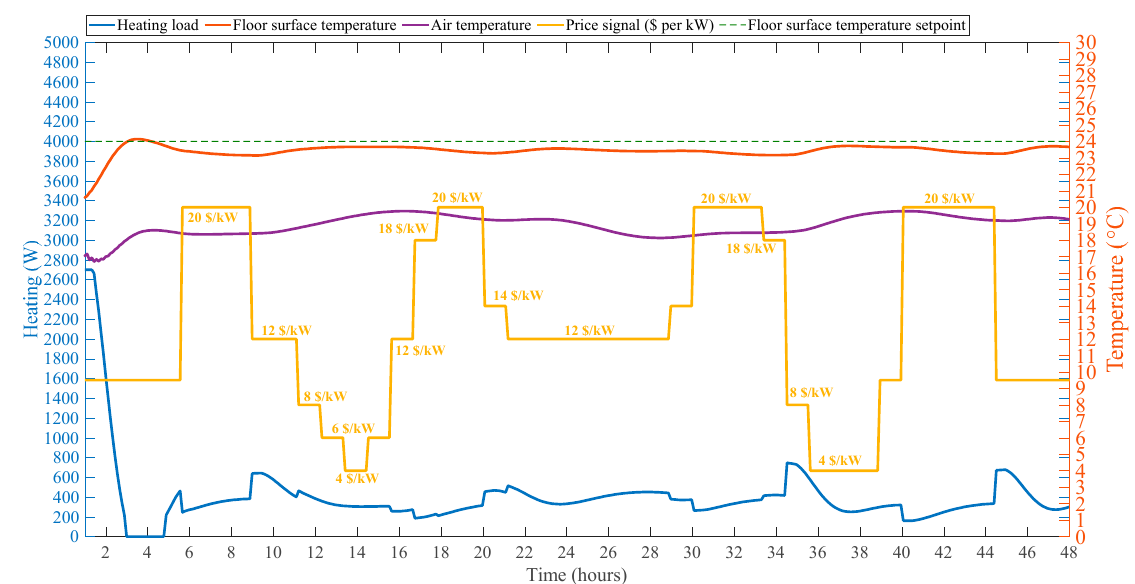
Figure 11. Application of the nearly reactive strategy to deal with the changing price signal.